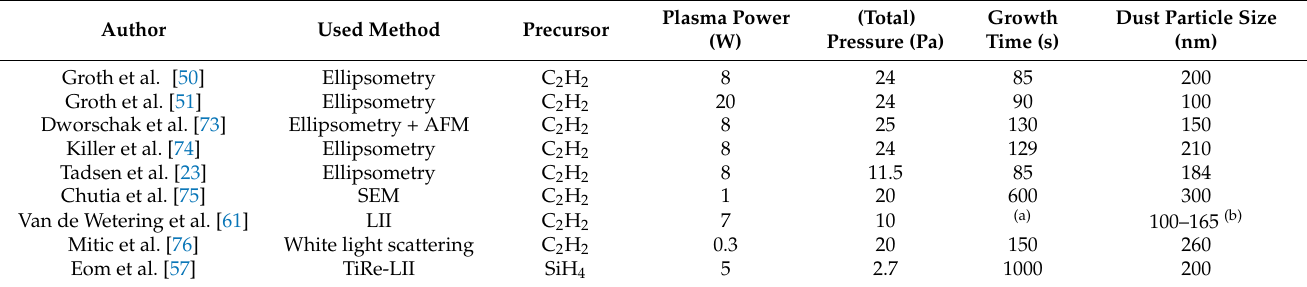
Table 1. Overview of the characteristics of low-pressure dust growth as reported in the